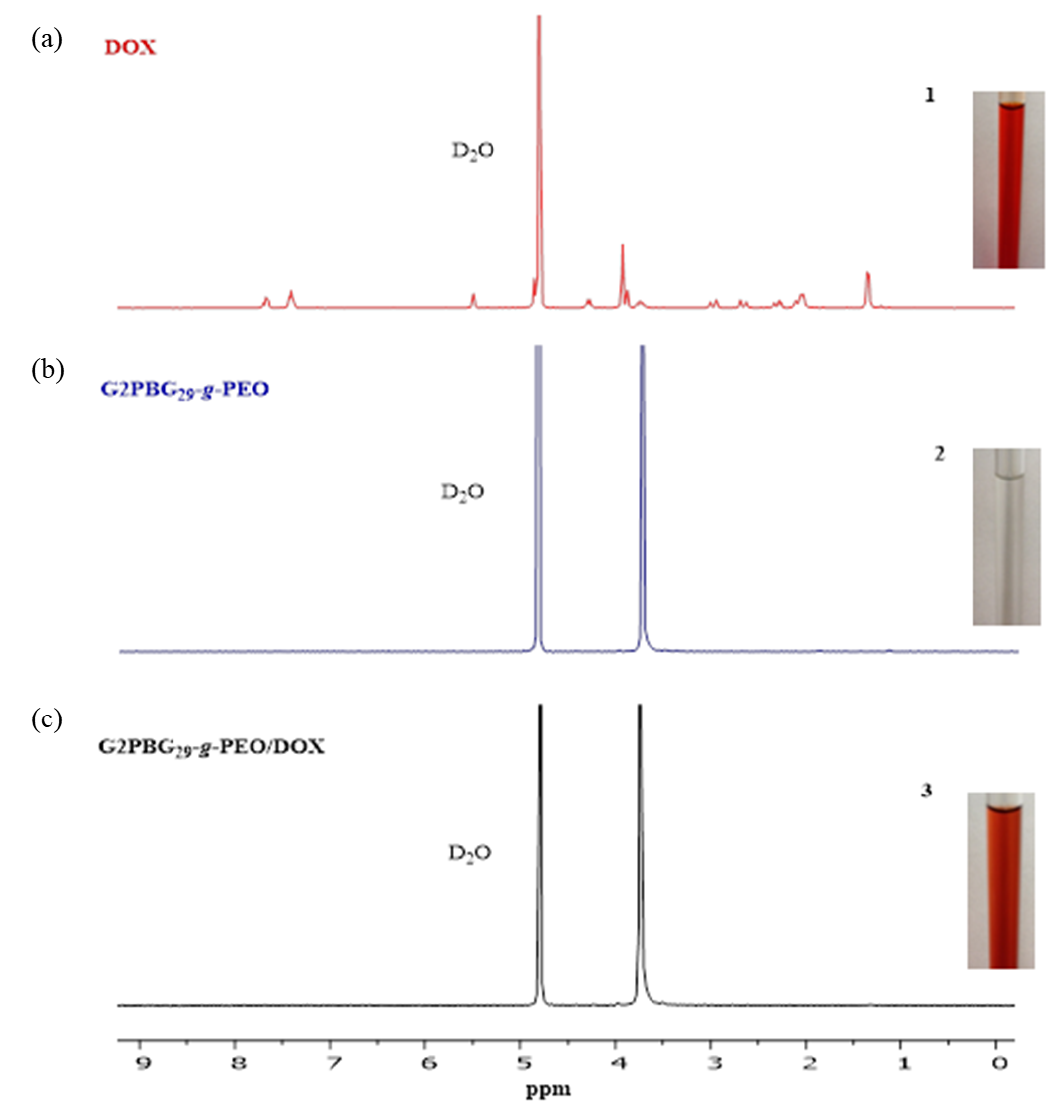
Figure 6. 1 H NMR spectra for ( a ) DOX in D 2 O, ( b ) G2PBG 29 - g -PEO in D 2 O and ( c ) G2PBG 29 - g - PEO/DOX in D 2 O. The insets show the appearance of the (1) DOX, (2) G2PBG 29 - g -PEO, and (3) G2PBG 29 - g -PEO/DOX samples in D 2 O.